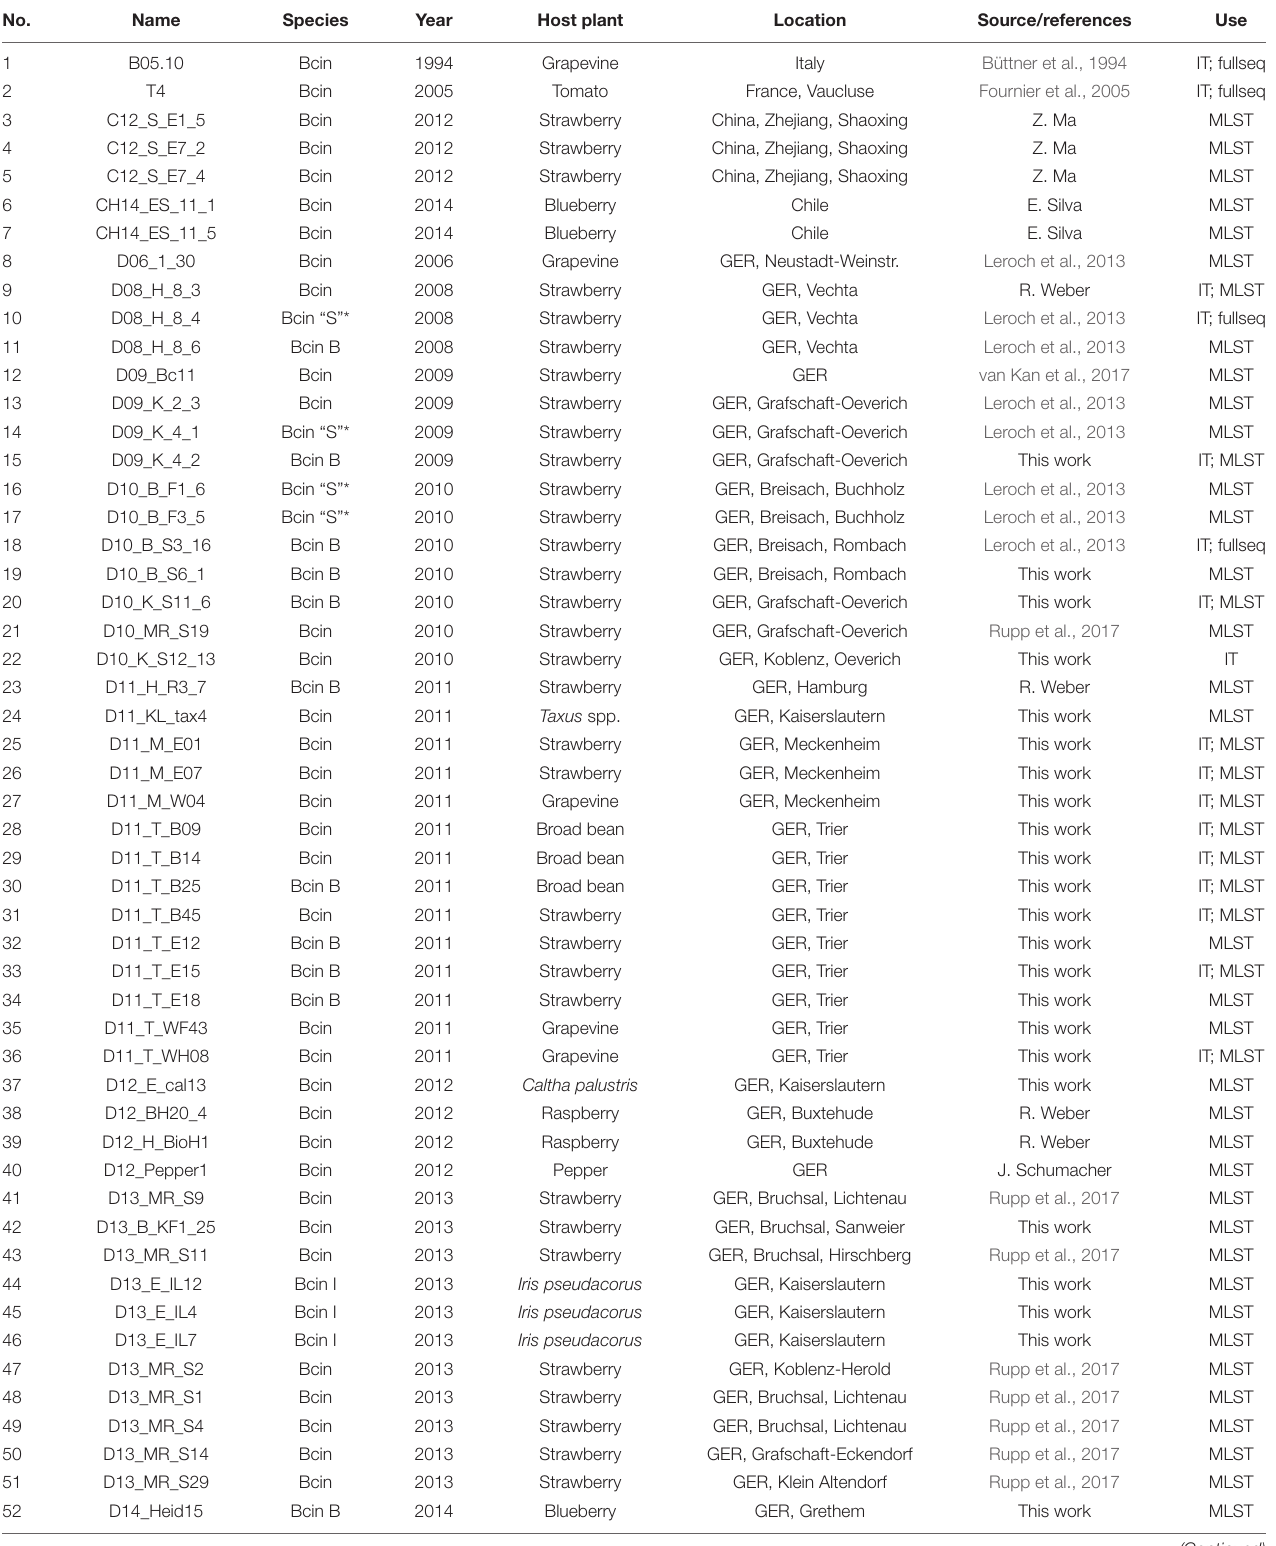
TABLE 1 | Botrytis strains analyzed by MLST and infection